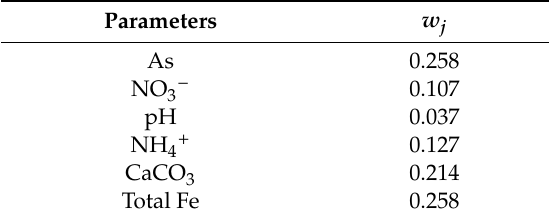
Table 7. Relative weight factors of di ff erent water quality